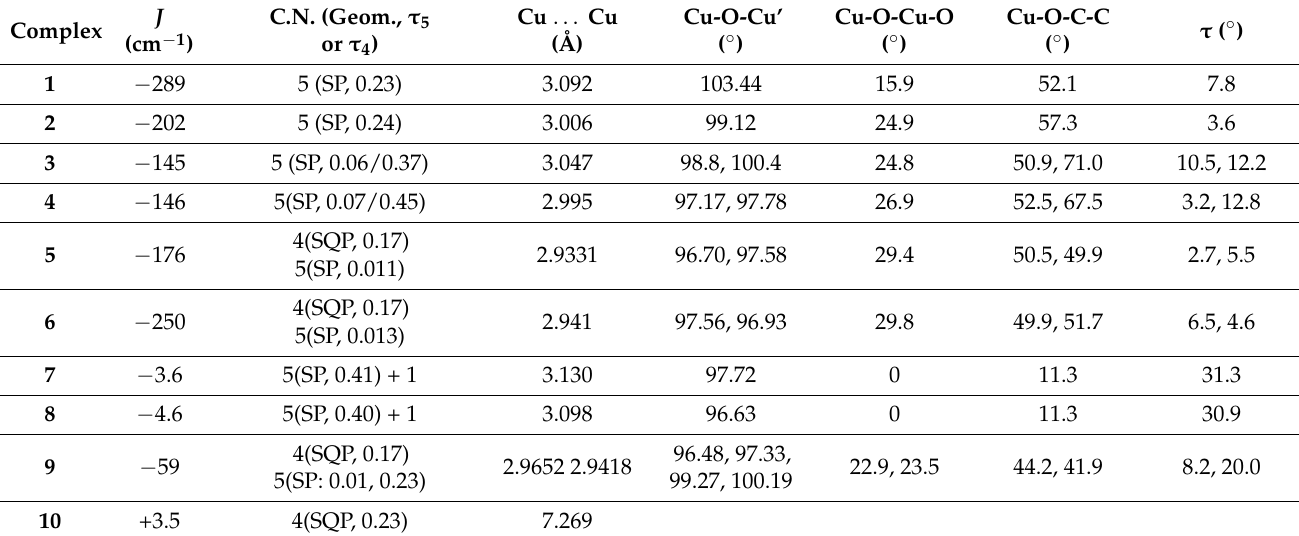
Table 2. Magnetostructural correlation of Cu 2 O 2 -phenoxido